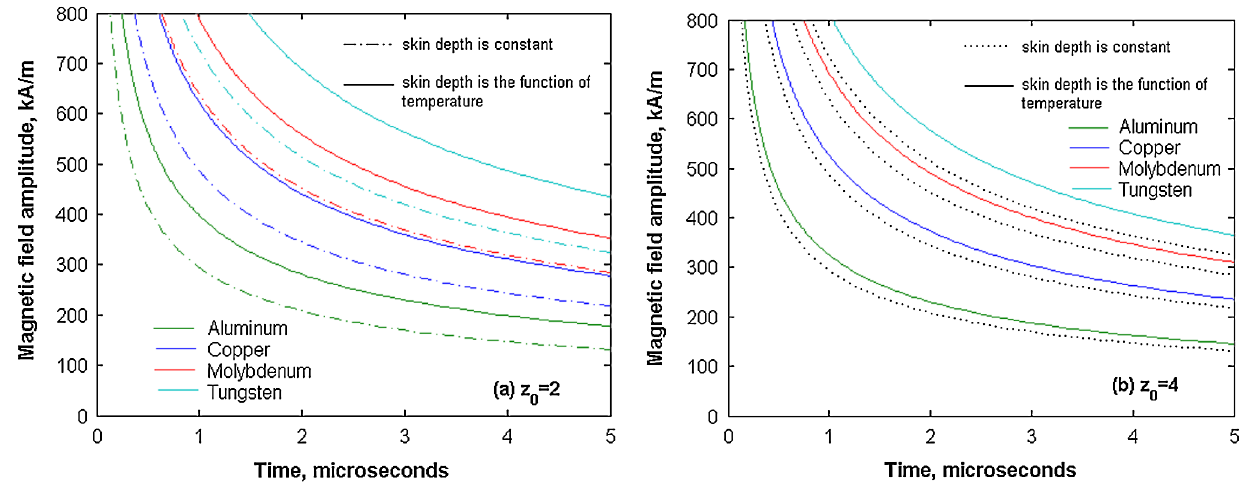
FIG. 4. (Color) Critical field amplitude leading to melting of spherical microparticles with the initial ( a=(cid:6) ) ratio equal to 2.0 (a) and 4.0 (b). The rf frequency is equal to 11.4